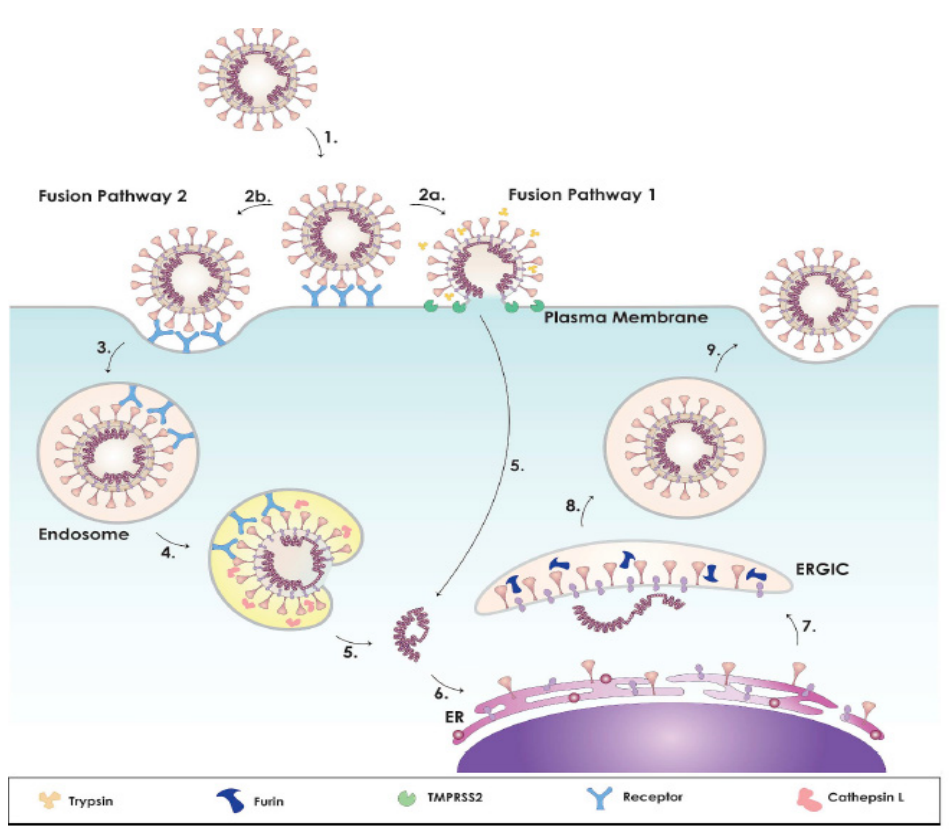
Figure 3. Model of coronavirus dual entry pathway. This model depicts the two methods of viral entry: Early pathway and late pathway. As the virus binds to its receptor (1), it can achieve entry via two routes: Plasma membrane or endosome. For SARS-CoV: The presence of exogeneous and membrane bound proteases, such as trypsin and TMPRSS2, triggers the early fusion pathway (2a). Otherwise, it will be endocytosed (2b, 3). For MERS-CoV: If furin cleaved the S protein at S1/S2 during biosynthesis, exogeneous and membrane-bound proteases, such as trypsin and TMPRSS2, will trigger early entry (2a). Otherwise, it will be cleaved at the S1/S2 site (2b) causing the virus to be endocytosed (3). For both: Within the endosome, the low pH activates cathepsin L (4), cleaving S2 ′ site, triggering the fusion pathway, and releasing the CoV genome. Upon viral entry, copies of the genome are made in the cytoplasm (5), where components of the S protein are synthesized in the rough endoplasmic reticulum (ER) (6). The structural proteins are assembled in the ER-Golgi intermediate compartment (ERGIC), where the S protein can be precleaved by furin, depending on cell type (7), followed by release of the virus from the cell (8, 9). For SARS-CoV-2: Studies currently show that SARS-CoV-2 can utilize membrane bound TMPRSS2 or endosomal cathepsin L for entry and that the S protein is processed during biosynthesis [29].